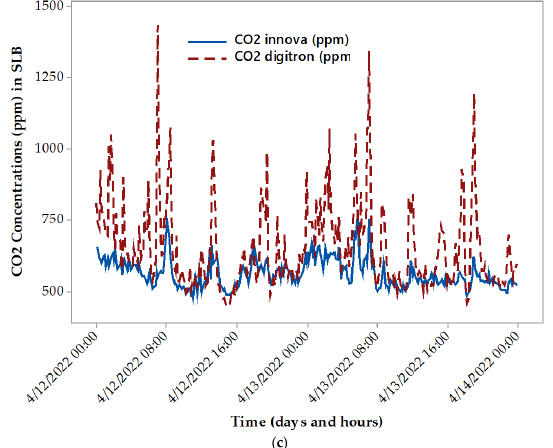
Figure 4. Trends of gas concentrations having r > 0.5 during two days of measurements. In detail, the graphs show NH 3 concentrations acquired in SLA ( a ) and SLC ( b ) and CO 2 concentrations ac- quired in SLC ( c ) by using the two measurement devices. Based on the outcomes, the NH 3 concentrations acquired by the INNOVA and the NH 3 concentrations acquired by the low-cost devices were strongly correlated in SLA. The linear regression model, which was applied to describe the relationship between the NH 3 concentrations acquired by the two devices, is shown in Figure 5. The regression equation ( p < 0.001 and R 2adj = 68.6%) is as follows: